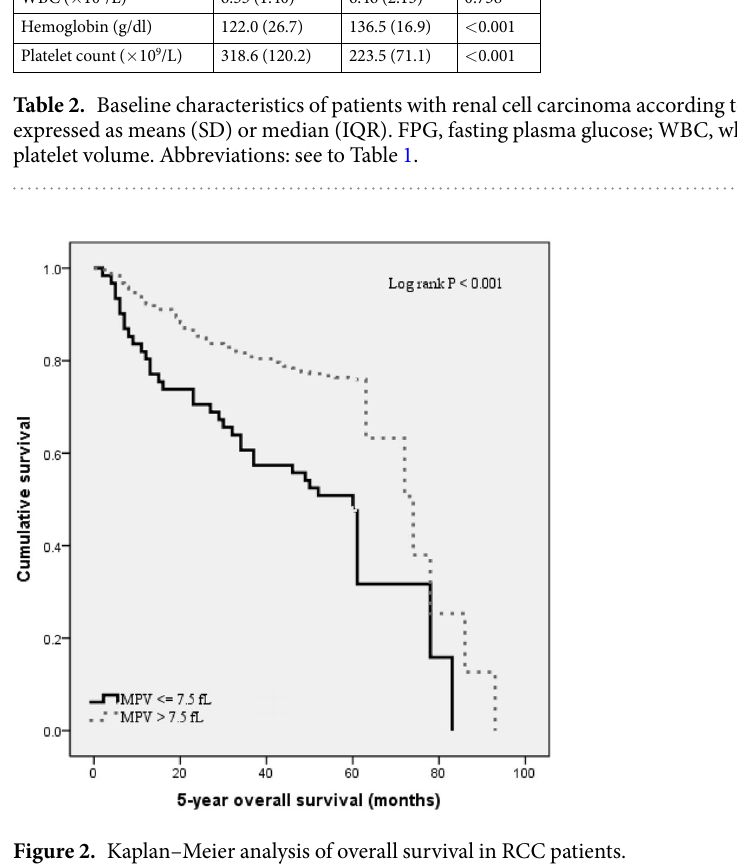
Figure 2. Kaplan–Meier analysis of overall survival in RCC